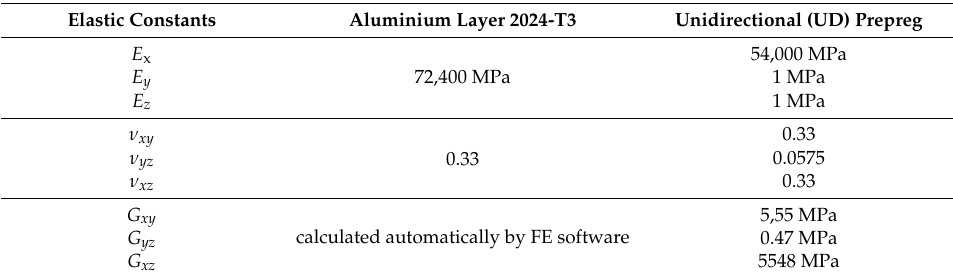
Table 3. Material properties for the Al alloy layers and the unidirectional prepreg layers used in the FE simulations [20].